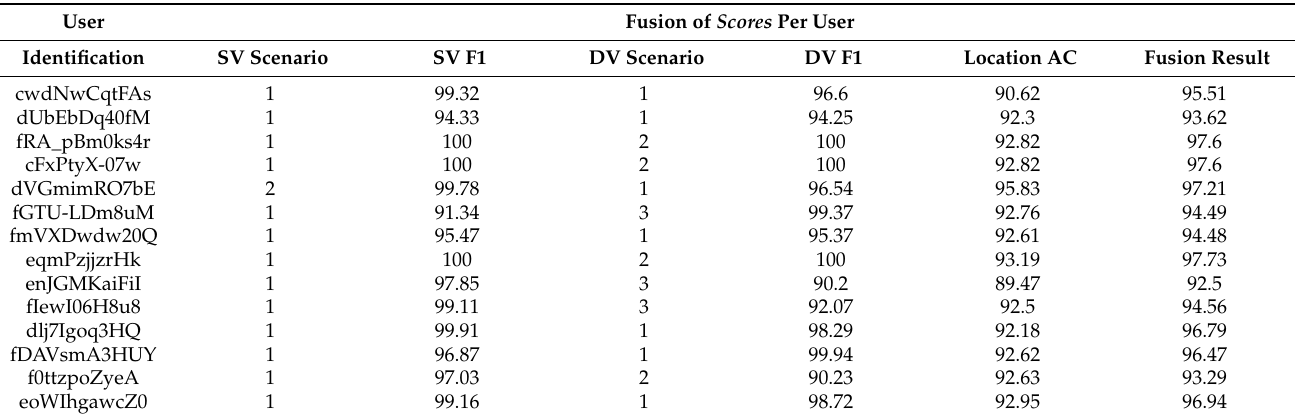
Table 18. Fusion of the SV, DV, and location